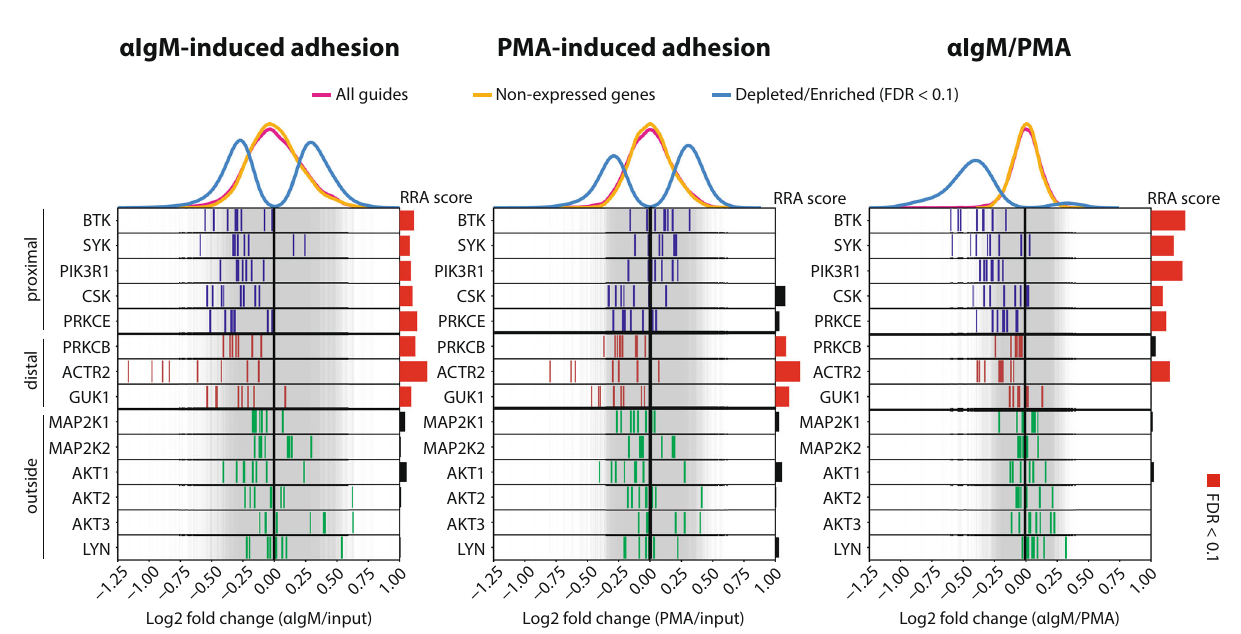
Fig. 3 Distribution of the guides targeting genes involved in either proximal-, distal-, or not involved in, antigen/BCR-integrin signaling. Log2 fold changes of the individual guides targeting genes involved in either proximal (blue lines), distal (red lines), or not involved in (green lines) BCR-integrin signaling. The RRA scores are the α RRA depletion scores. The graphs show the results for α IgM-induced adhesion relative to pre-adhesion (left), PMA- induced adhesion relative to pre-adhesion (middle), and α IgM-induced adhesion relative to PMA-induced adhesion (right). Source data are provided as a Source data fi